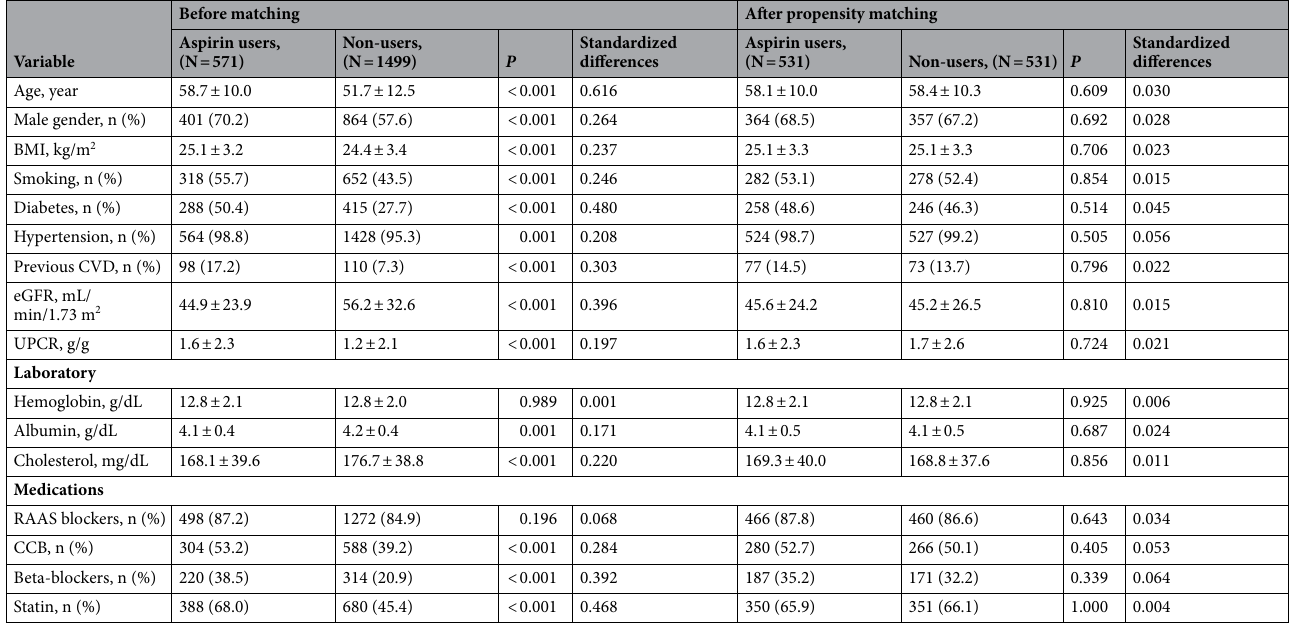
Table 1. Baseline characteristics of study participants. Conversion factors for units were as follows: hemoglobin in g/dL to g/L, × 10; albumin in mg/dL to g/L, ×10; cholesterol in mg/dL to mmol/L ×